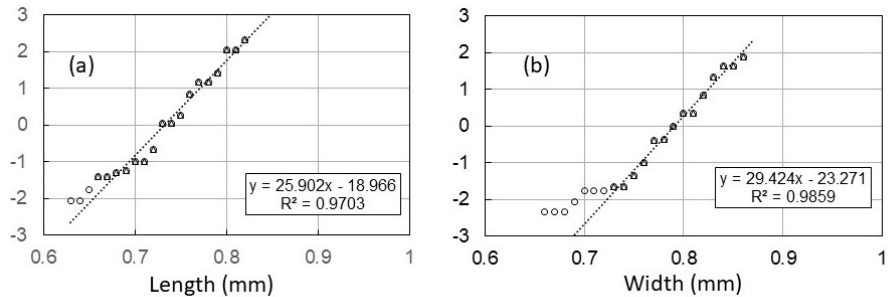
Figure 2. Normalized cumulative frequency distribution (z value on the vertical axis) of the hole size of Specimen #1. Sizes in the ( a ) vertical and ( b ) horizontal directions of the square holes.